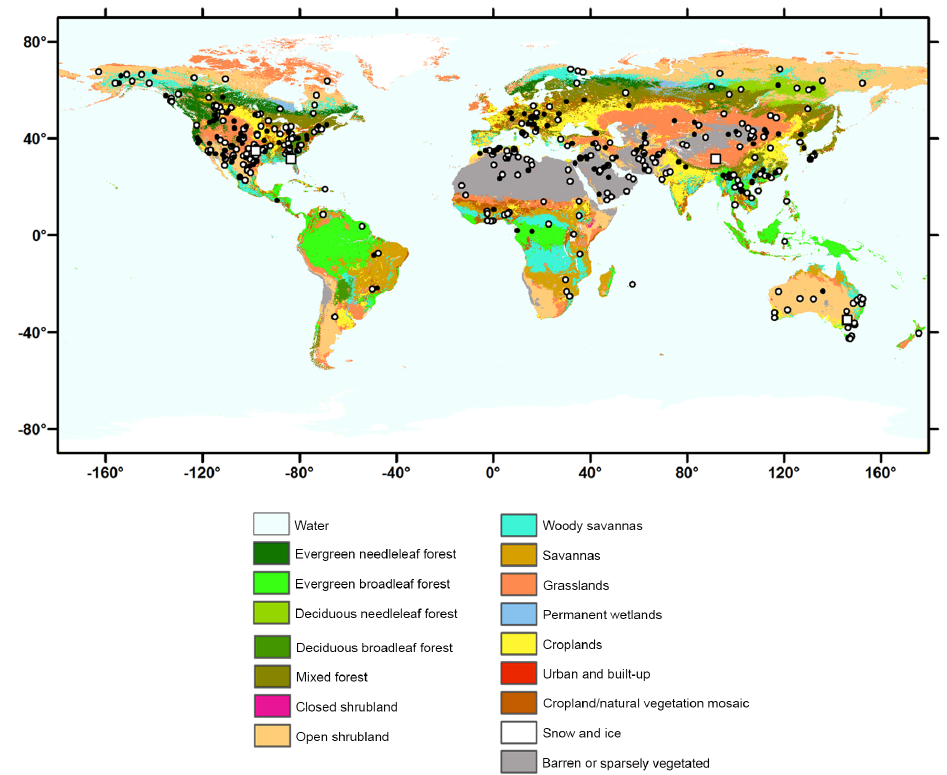
Figure 2. Global distribution of WMO weather station locations where collocated AIRS observations and WMO air temperature measure- ments were used for calibrating (white circles) and validating (black circles) the LPDR PWV, T mx , and T mn estimates; the locations of the four independent soil moisture networks used for validating the LPDR VSM retrievals are also shown (white